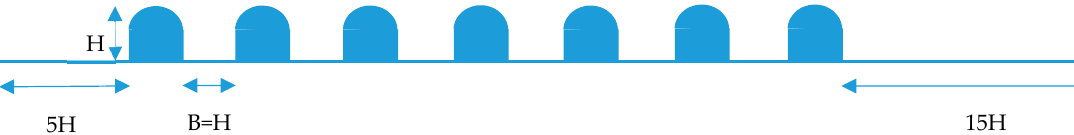
Figure 27. Geometry configuration of Llaguno-Munitxa et al.’s experiment [43].